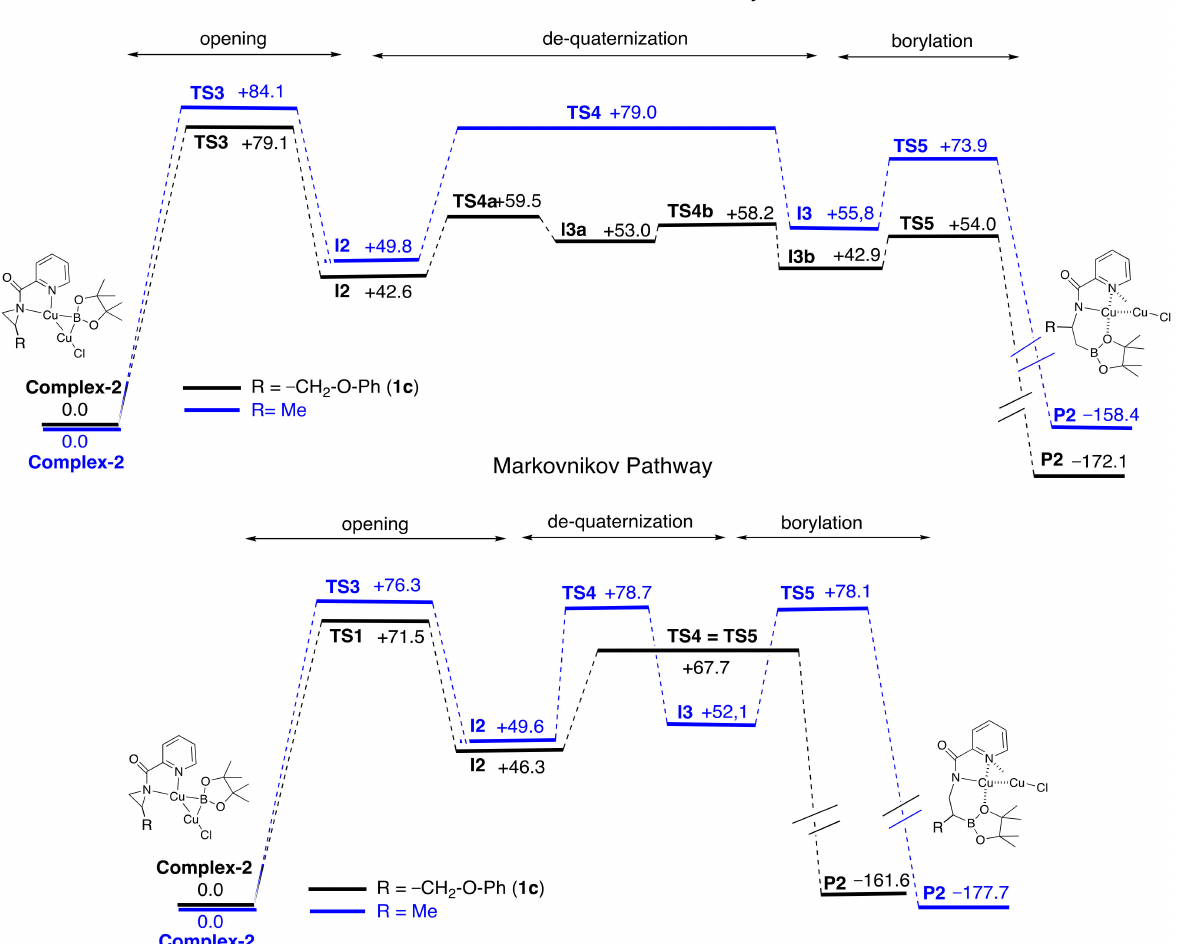
Figure 3. Reaction energy profile with the second model for the reaction of N -(2-picolinoyl)-methyl aziridine and 1c (the ∆ G values are in kJ/mol).